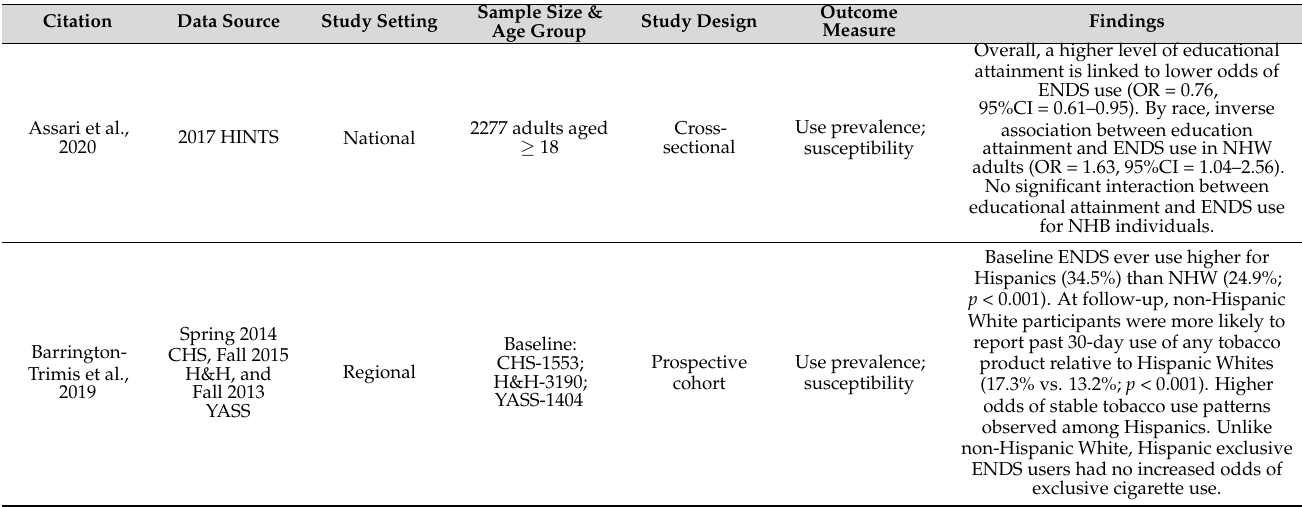
Table 1. Key findings from the